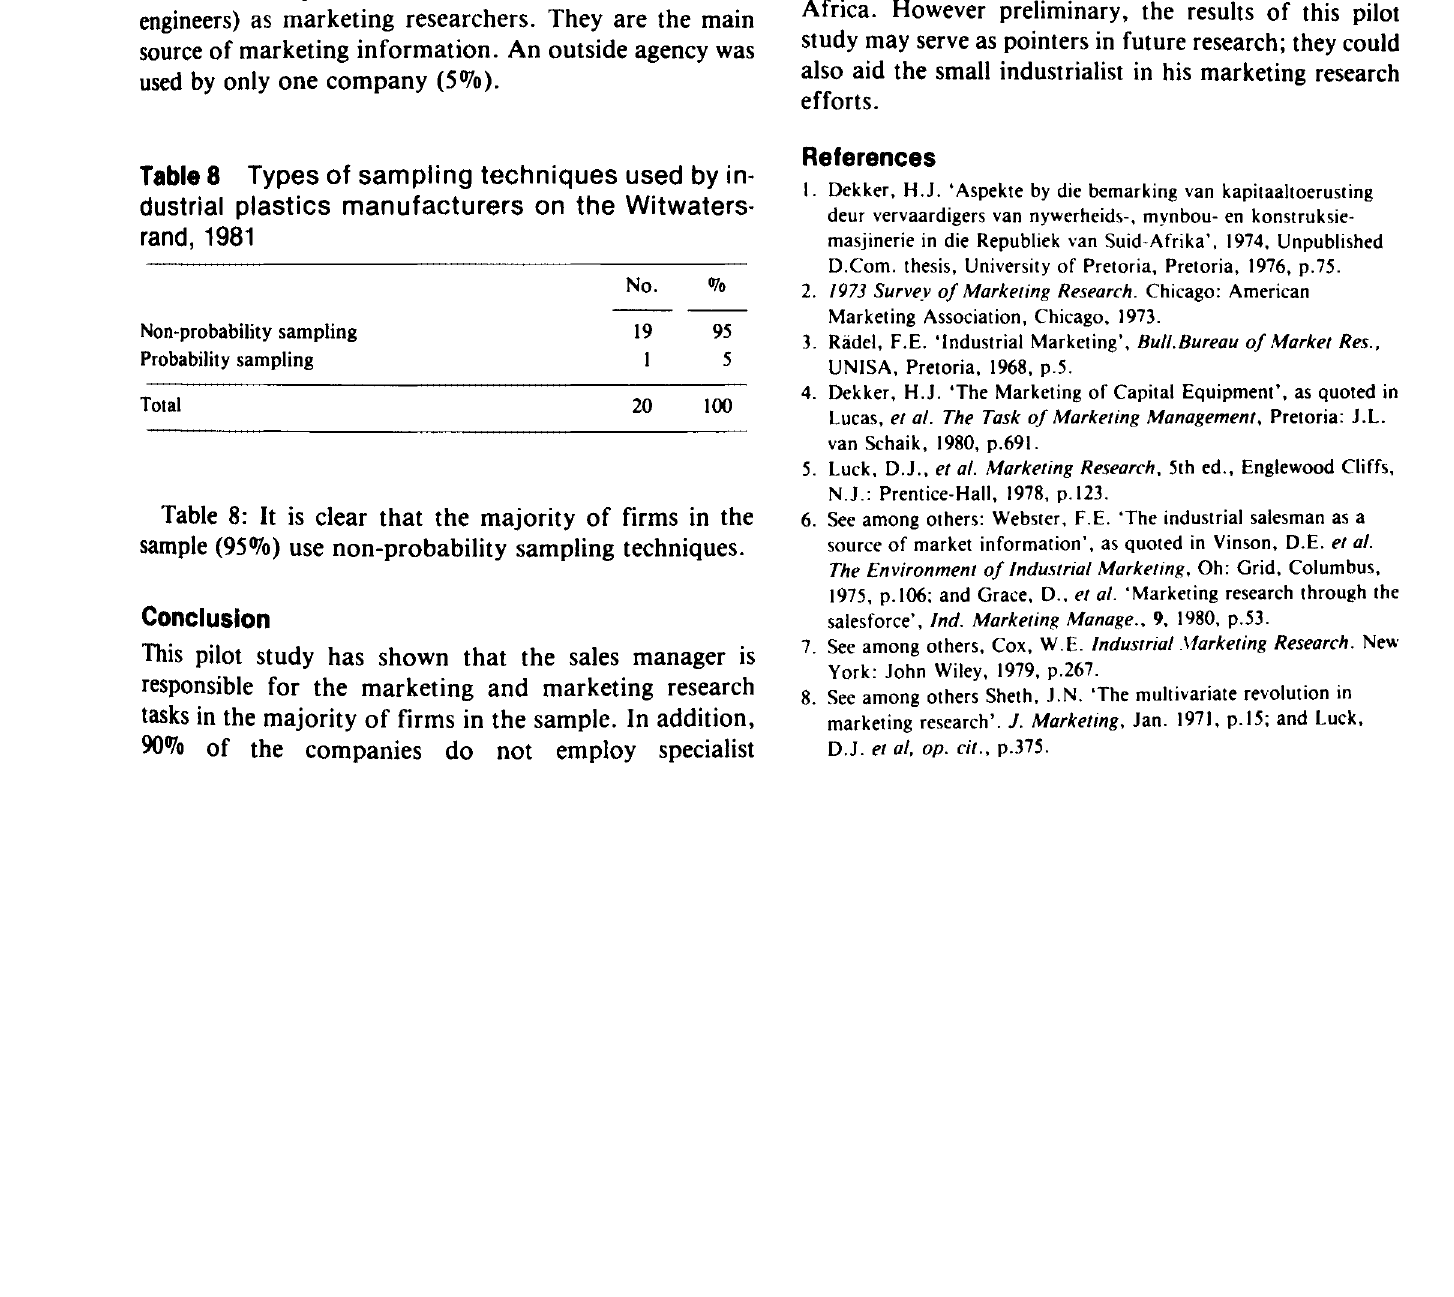
Table 7: Seven companies in the sample (350Jo) used their sales called sales engineers) as marketing researchers. They are the main source of marketing information. An outside agency was used by only one company (50/o).